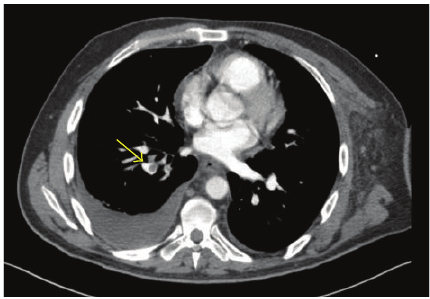
Figure 2: CT angiography demonstrating lobar and segmental pulmonary emboli (arrow) in the right lower